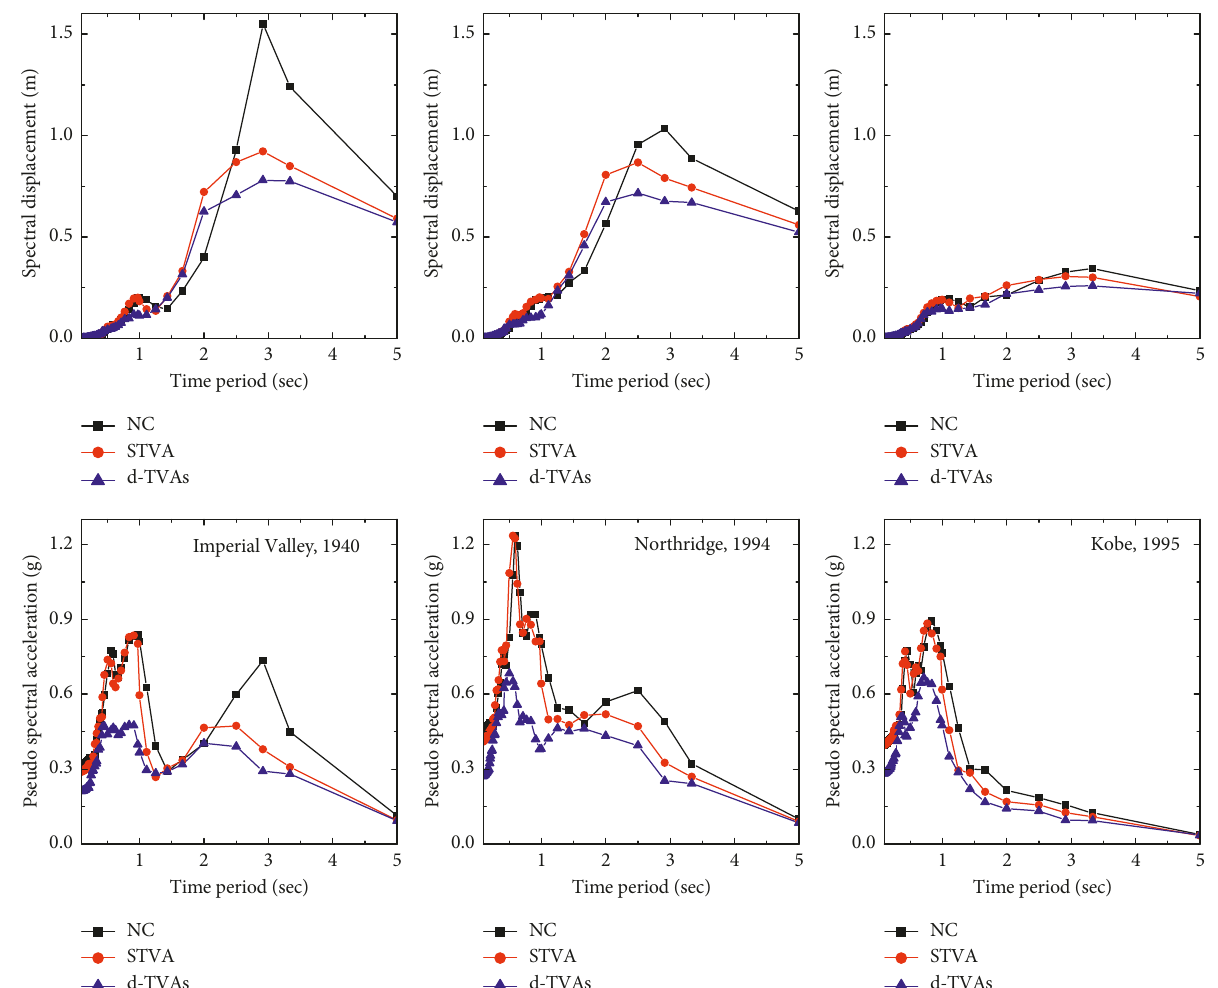
Figure 3: Spectral displacement and pseudospectral acceleration for the NC, STVA, and d-TVAs subject to different ground